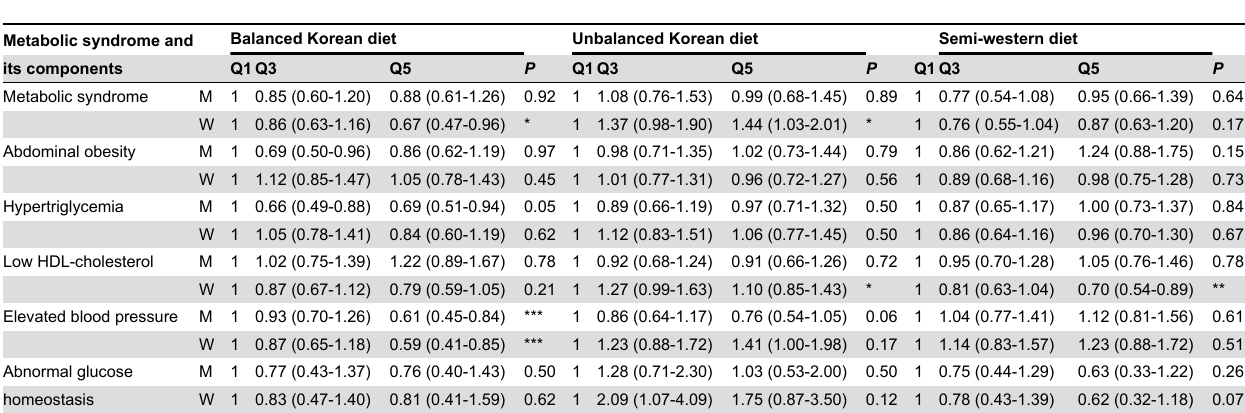
Values are expressed as odd ratios and 95% confidence